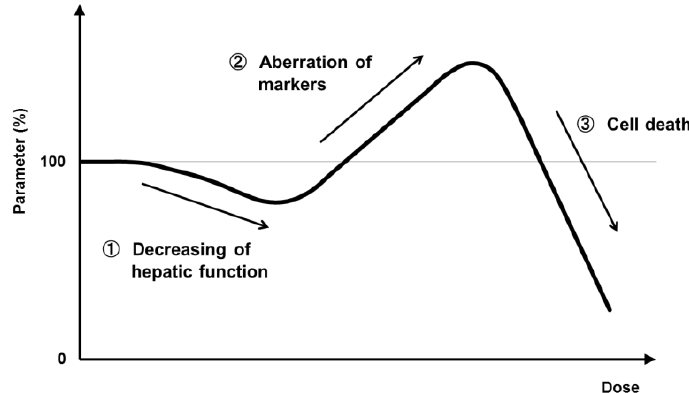
ff erent stages (endpoints) of in vitro Figure 7. Hypothesis regarding the different stages (endpoints) of in vitro hepatotoxicity. Figure 7. Hypothesis regarding the di